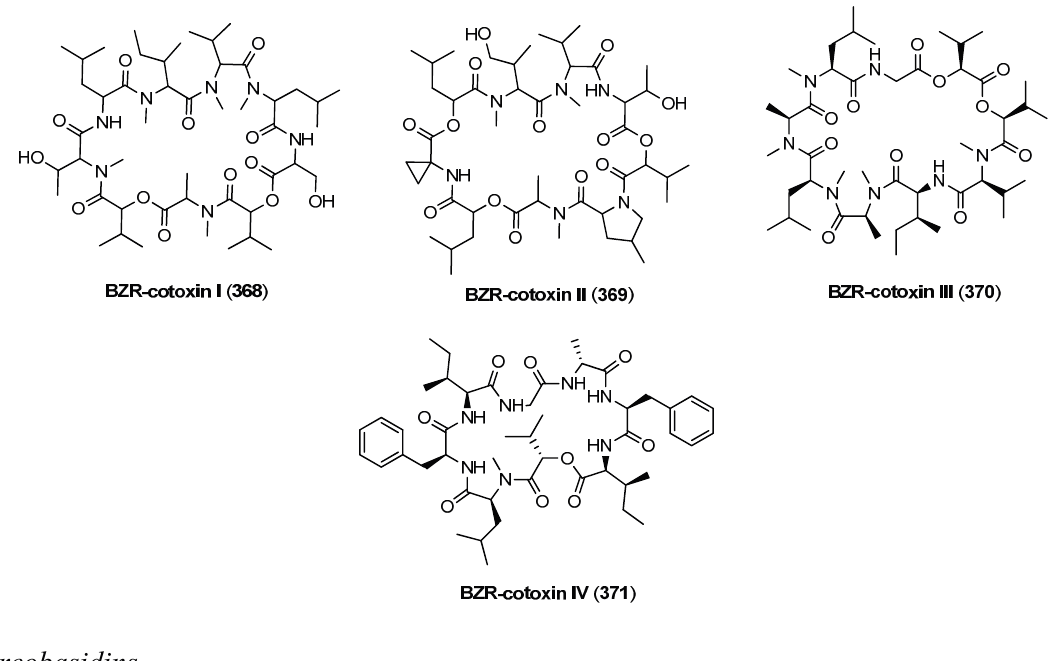
Figure 32. Structures of BZR-cotoxin I-IV.